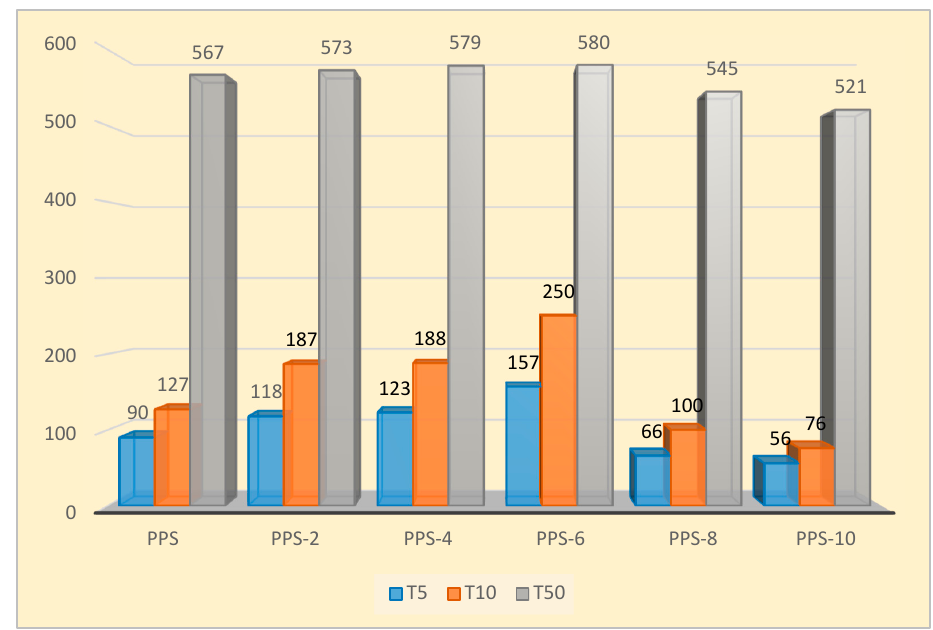
Figure 7. TGA curves of PPS@BC nanocomposites.